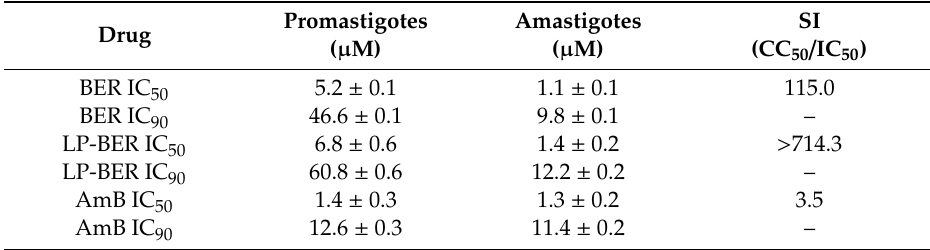
Table 4. In vitro antileishmanial activity expressed as concentrations inhibiting the parasite growth by 50 and 90% (IC 50 and IC 90 , respectively) on L. infantum promastigotes and amastigotes and selectivity index (SI) in bone marrow-derived macrophages (BMDM) after 48 h of treatment with free BER, LP-BER and amphotericin B (AmB, as positive